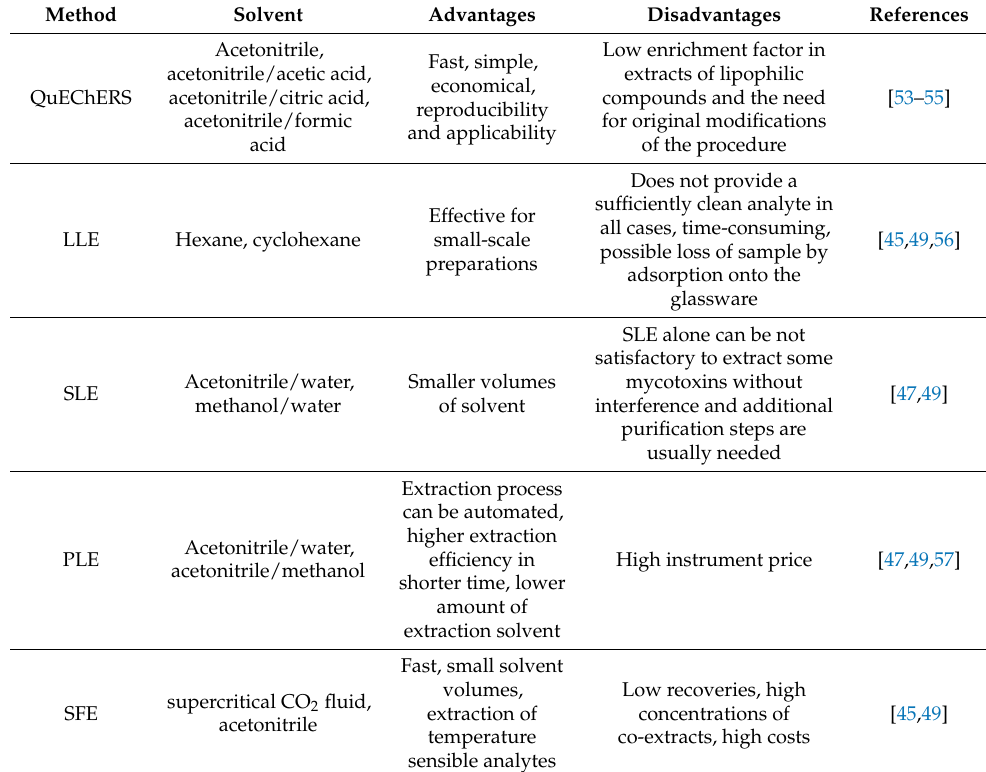
Table 1. Extraction methods, solvent, advantages, and